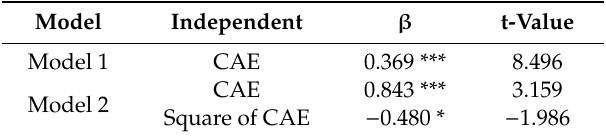
Table 4. Quadratic regression result, with information seeking being the dependent